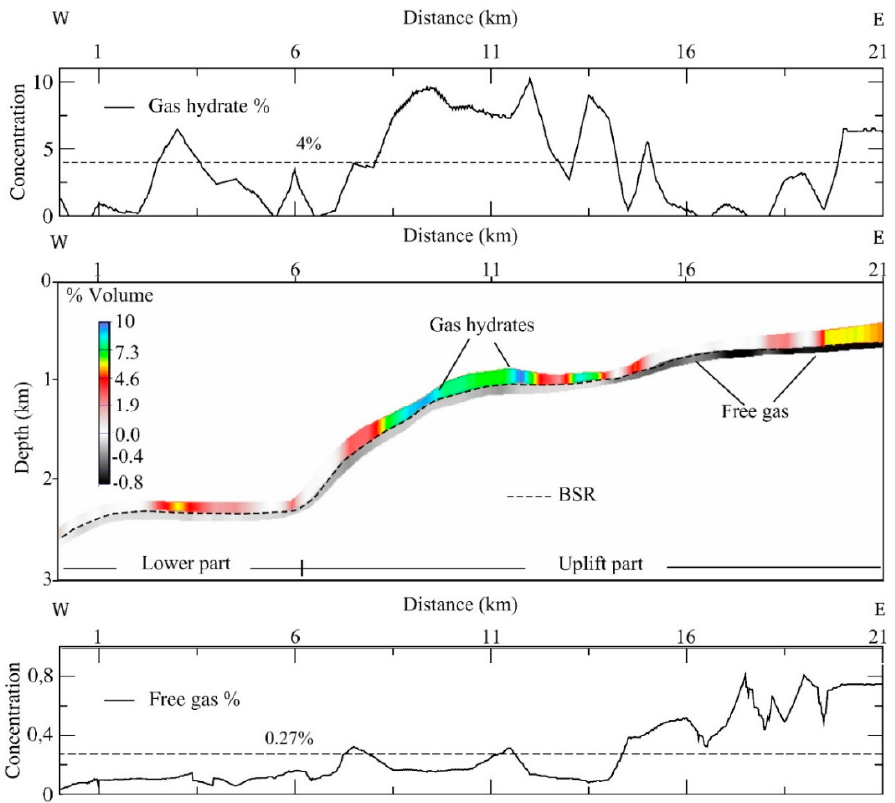
Figure 4. Gas hydrate and free gas concentration models and profiles relative to RC2901-751 seismic profile. Top panel: gas hydrate concentration values. Middle panel: gas-phase concentration model. Bottom panel: free gas concentration values. Dashed lines in the top and bottom panels correspond to the average gas hydrate and free gas concentrations, respectively.